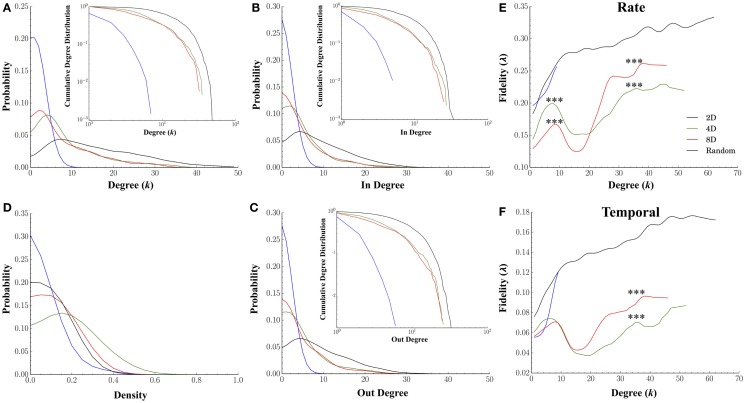
Node degree and fidelity. Many common network measures were affected by the structural constraints imposed by microprinting. (A) Node degree distribution for the 2D, 4D, 8D, and Random topologies (inset: cumulative degree distribution plotted within a log-log scale). Node degree represents the number of edges/connections per node in an undirected graph (distributions from values drawn from directed graphs were very similar in shape and magnitude). The overall average node degree was near values of 2 for the 2D, 8 for the 8D and 4D, and over 15 connections in the Random topologies. Remarkably similar distributions were obtained for the in-degree (B) and out-degree (C) suggesting the number of incoming connections were balanced with the number outgoing connections. (D) There were significant differences in density of node connectivity (a measure of how many connections have been established vs. the theoretical maximum) with the highest densities observed in the 4D and 8D followed 2D topologies and the lowest in Random. (E) plots the average fidelity associated with a rate-based neural code and (F) temporal-based code associated with increasing node degrees. In each topology, the fidelity associated with each node improved with increasing node degree (i.e., number of connections possessed by that node). At lower node degrees, the 4D and 8D networks produced an initial peak in fidelity that occurred at node degrees of 6 and 8, respectively, which were near original design values 4 and 8. Increases in node degree beyond those values resulted in a momentary decrease in fidelity (local minima) before once again increasing for the few nodes highest node degrees. In 2D and Random networks fidelity continued to increase up to the maximum node degree observed within these topologies.